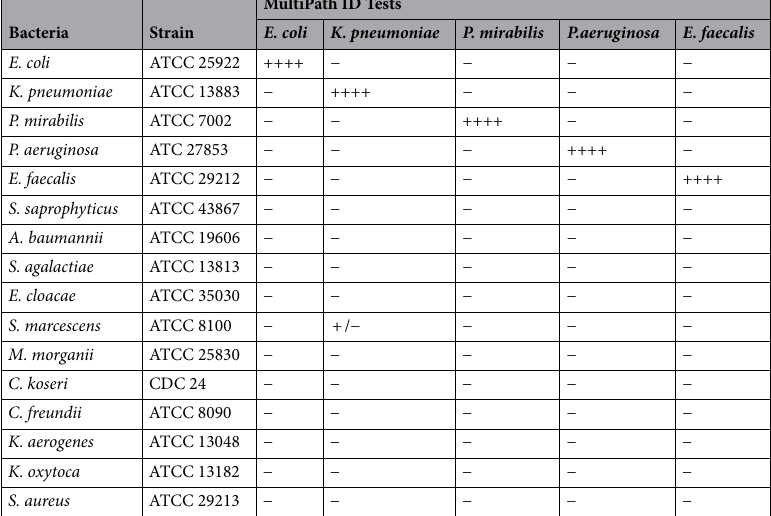
Table 2. Specificity of MultiPath ID assays. 16 bacterial species were individually added to pooled urine at 5 × 10 6 to 1 × 10 7 CFU/mL, processed by SEC and tested in triplicate with the 5 MultiPath tests in the manual plate format. No-cell samples were tested in triplicate as controls. Specific signals, indicated by “++++” averaged about 136,000 above the no-cell controls. In contrast, non-specific signals, indicated by “−”, were similar to no-cell values (average signal of -7). The single cross-reactivity between the K. pneumoniae test and S. marcescens cells, shown with a “ + /−”, had a signal of 1,813 relative to the no-cell control.